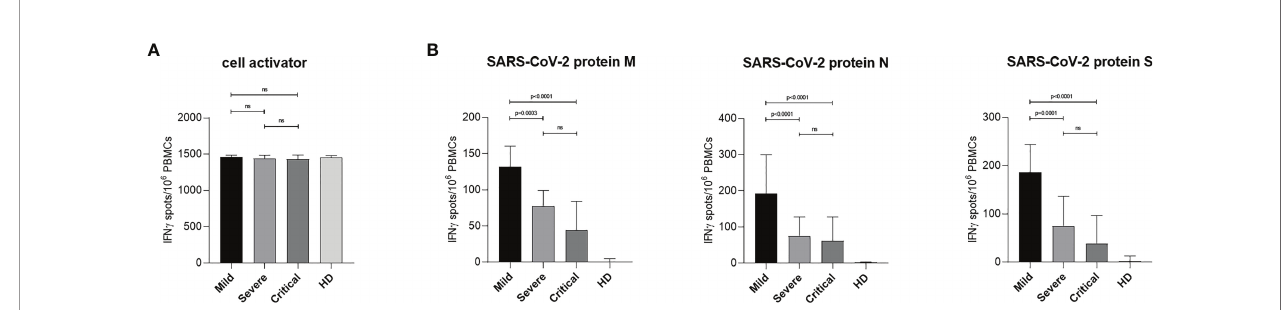
FIGURE 1 | IFN g production in SARS-CoV-2 speci fi c PBMCs from COVID-19 patients upon activation with virus-speci fi c peptides. PBMCs from COVID-19 patients and HD were isolated from whole EDTA-blood using red blood cell lysis solution. ELISpot Multiscreen ® plates were coated overnight with anti-human IFN g mAb 1-D1K (2 µg/ ml). On the following day, PBMCs were stimulated overnight with stimuli as indicated. Spots were revealed by subsequent incubation with biotinylated anti-human IFN g mAb 7-B6-1 (1 µg/ml), Streptavidin-Alkaline Phosphatase (1:1,000) and ready to use BCIP ® /NBT. Results are shown as median IFN g spots normalized by 1 × 10 6 cells from the different groups, Mild (n = 11), Severe (n = 15), Critical (n = 11), HD (n = 21). Error bars represent interquartile range. (A) IFN g ELISpots of patient PBMCs stimulated with a cell activator cocktail (1:500) are shown. (B) IFN g ELISpots of patient PBMCs stimulated using peptide pools covering the complete SARS-CoV-2 proteins M (left), N (middle) or S (right) are presented. Statistical differences were determined using one-way ANOVA with Dunnett´s post test. ns, not signi fi